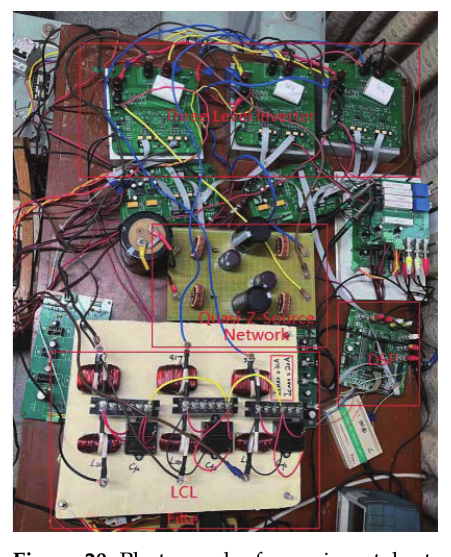
Figure 20. Photograph of experimental setup.